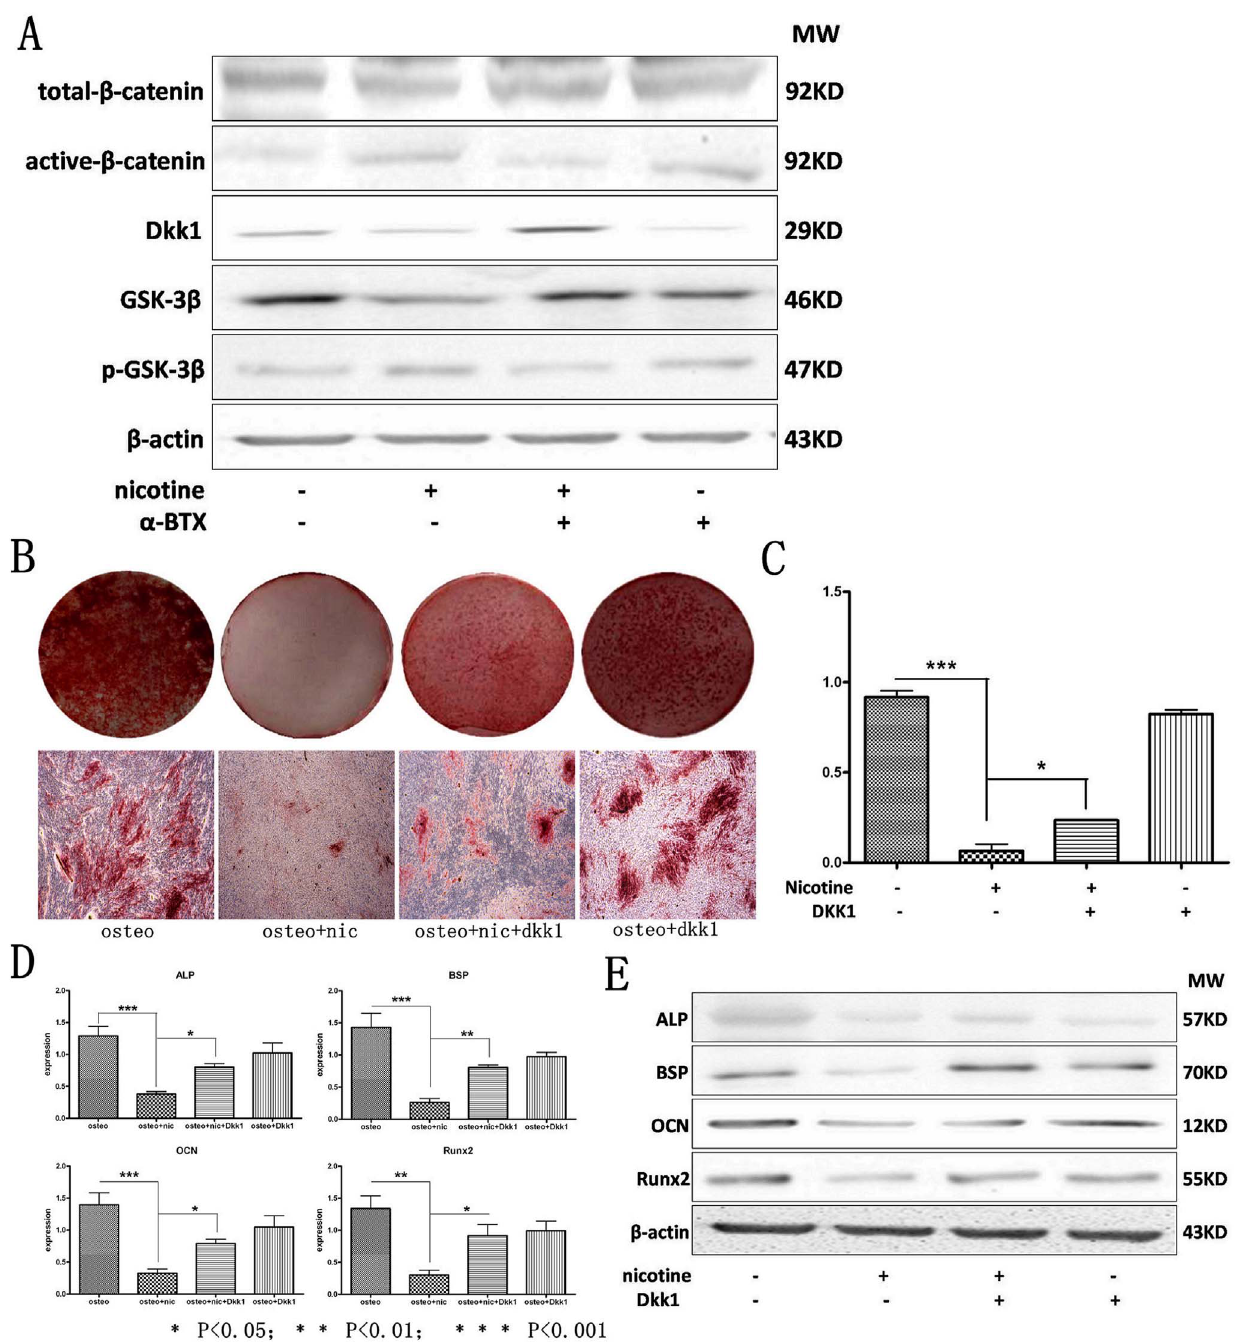
Figure 5. Nicotine deteriorates the osteogenic differentiation of hPDLSCs through a 7 nAChR regulating Wnt/ b -catenin pathway. A : The expression of wnt signaling pathway related proteins were determined by western blot, wnt signaling pathway was activated by nicotine in the downstream of a 7 nAChR; B, C : hPDLSCs treated with/without nicotine and dkk1 were cultured in osteogenic medium and osteogenic differentiation was determined by Alizarin red S staining after 21 days. D : The expression of osteogenic related genes Runx2, BSP, ALP and OCN were determined by qRT-PCR after 14 days of culturing with osteogenic supplement. E : The expression of osteogenic related proteins Runx2, BSP, ALP and OCN were determined by western blot after 14 days of culturing with osteogenic supplement. Data represent the means 6 SD. *p , 0.05 (n=3). doi:10.1371/journal.pone.0083102.g005 bone resorption, loss of periodontal attachment and deeper non-smokers [26] and cigarette smoking played a negative role in periodontal pockets [25]. Results of epidemiological investigations teeth preserving for periodontitis patients [27,28]. Previous studies which were based on cross sectional studies indicated that had already demonstrated that nicotine in cigarette could prevalence of periodontitis for smokers was 2–7 times more than deteriorate the structure of periodontal fibroblast and further